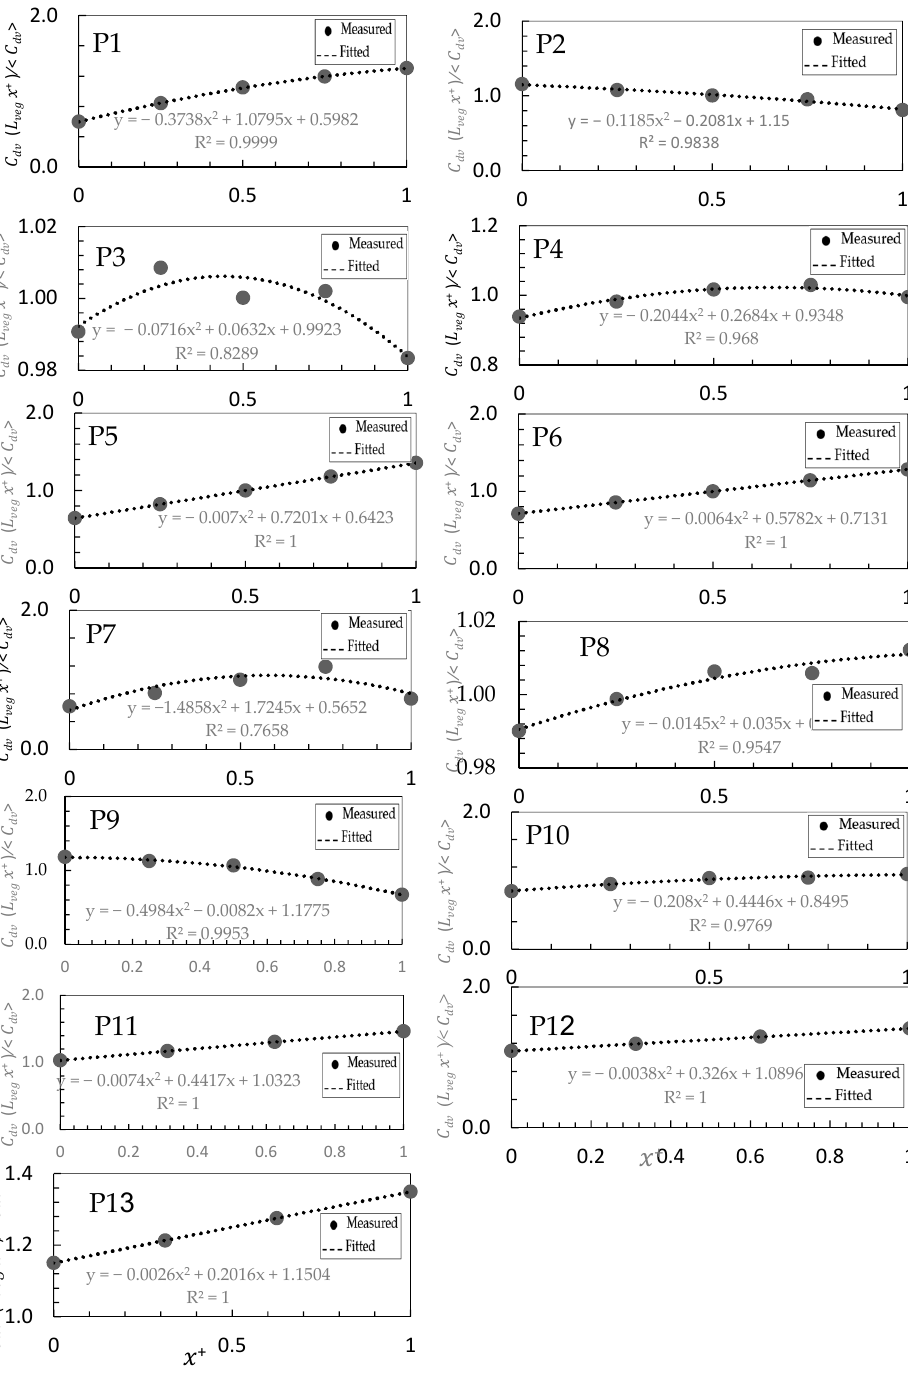
(cid:0) (cid:1) x + L veg Figure 7. Variations in C dv / < C dv > with x + . Figure 7. Variations in 𝐶 (cid:3031)(cid:3049) (cid:3435)𝑥 (cid:2878) 𝐿 (cid:3049)(cid:3032)(cid:3034) (cid:3439)/< 𝐶 (cid:3031)(cid:3049) > with 𝑥 (cid:2878) . Equation (14) presents a nonmonotonic result and explains why the drag coefficients Figure 8 shows the variation in the drag coefficient 𝐶 (cid:3031)(cid:3049) with 𝑅𝑒 (cid:3031) ranging from 316 (cid:0) (cid:1) C dv and C dv x + L veg / < C dv > of the submerged flexible vegetation in gravel bed rivers to 3757. The drag coefficient 𝐶 (cid:3031)(cid:2879)(cid:3036)(cid:3046)(cid:3042) of isolated vegetation in Figure 8 was estimated by show a parabolic form. This phenomenon has also been studied by other researchers [43]. using Equation (16). The drag coefficients 𝐶 (cid:3031)(cid:3049) for vegetation patches P1 to P4, P6, and P8 It is obvious that the nonmonotonic change in C dv is due to the effect of nonuniform flow to P10 are lower than 𝐶 (cid:3031)(cid:2879)(cid:3036)(cid:3046)(cid:3042) , implying a sheltering effect. in the river. The Reynolds number of each cylindrical element Re d = U ( x ) D / ϑ m